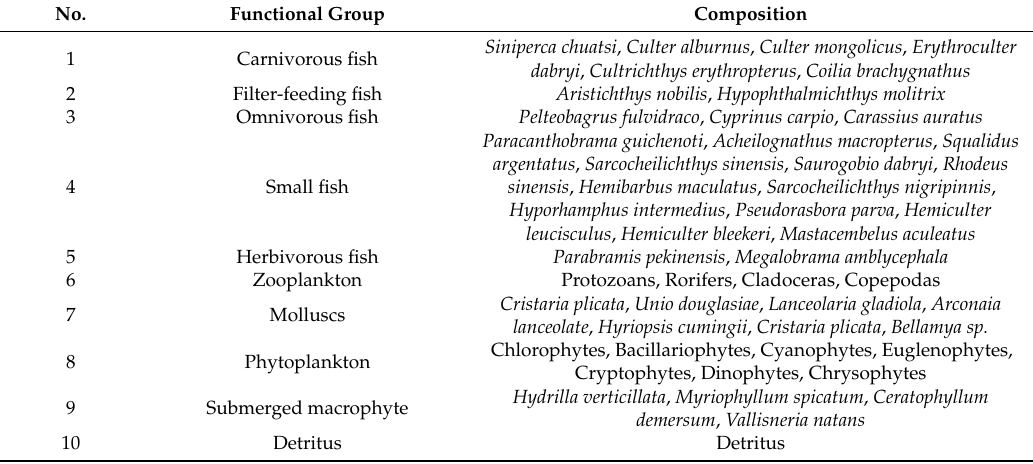
Table A1. Functional groups of the Lake Datong